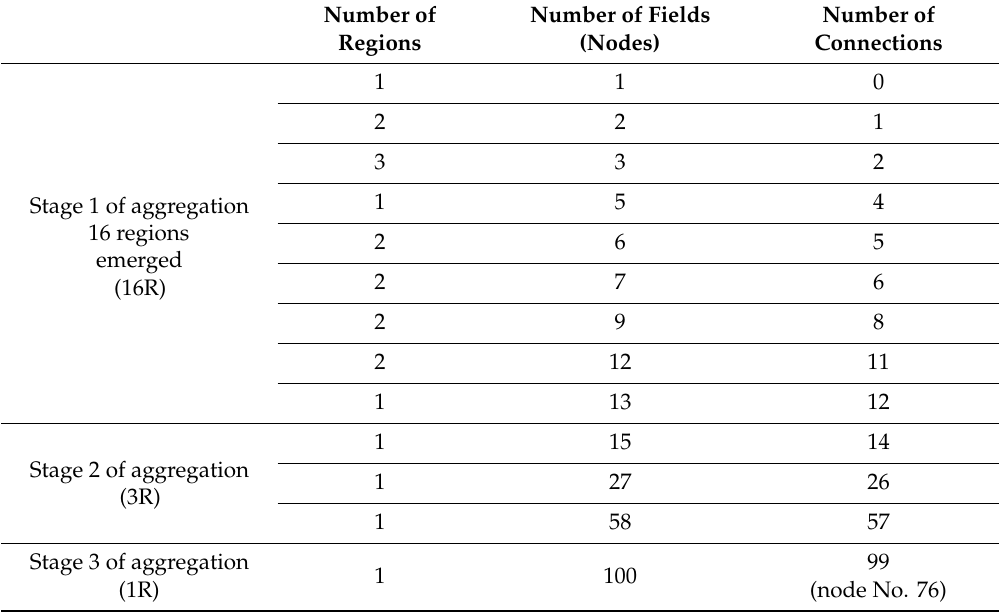
Table 5. Characteristics of the structure of networks formed according to the maximum value decrease